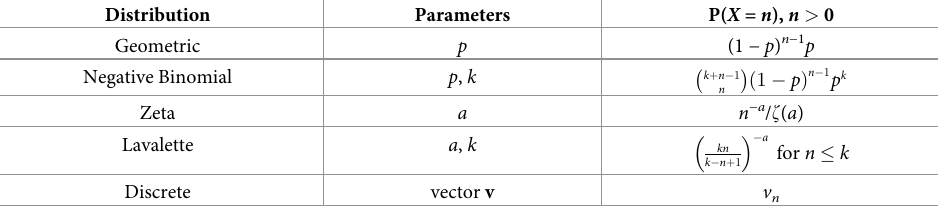
Algorithm 5 insertNode(Node, l ): this function inserts a new genome subtree at the given terminal genome search tree node “Node” at which the insertion is sampled, given the inser- tion length l . We assume that Node is part of the current layer, and that new nodes are created at the current layer.